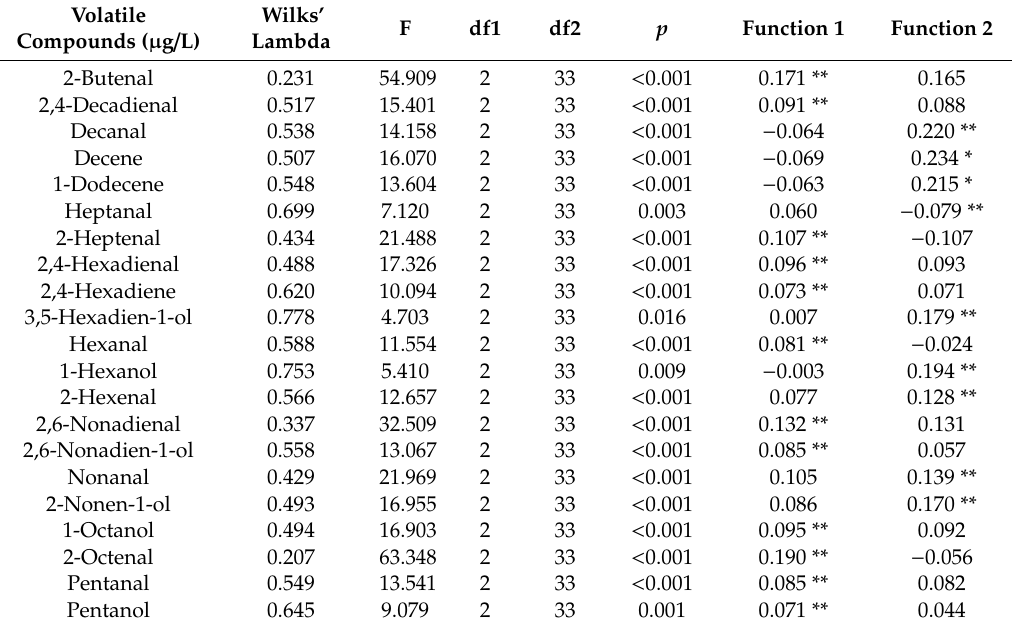
Table 4. Contribution of volatile compounds to the canonical discriminant function structure